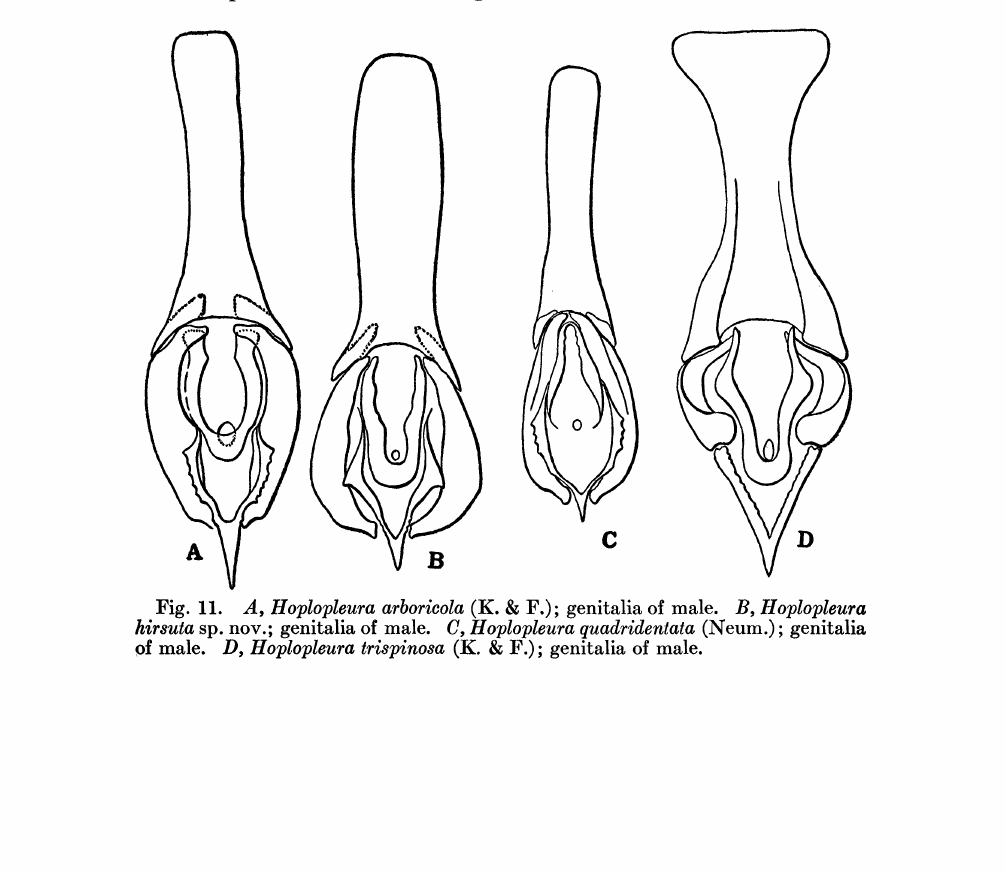
Fig. 10. Hoplopleura hirta n. sp,; sternal